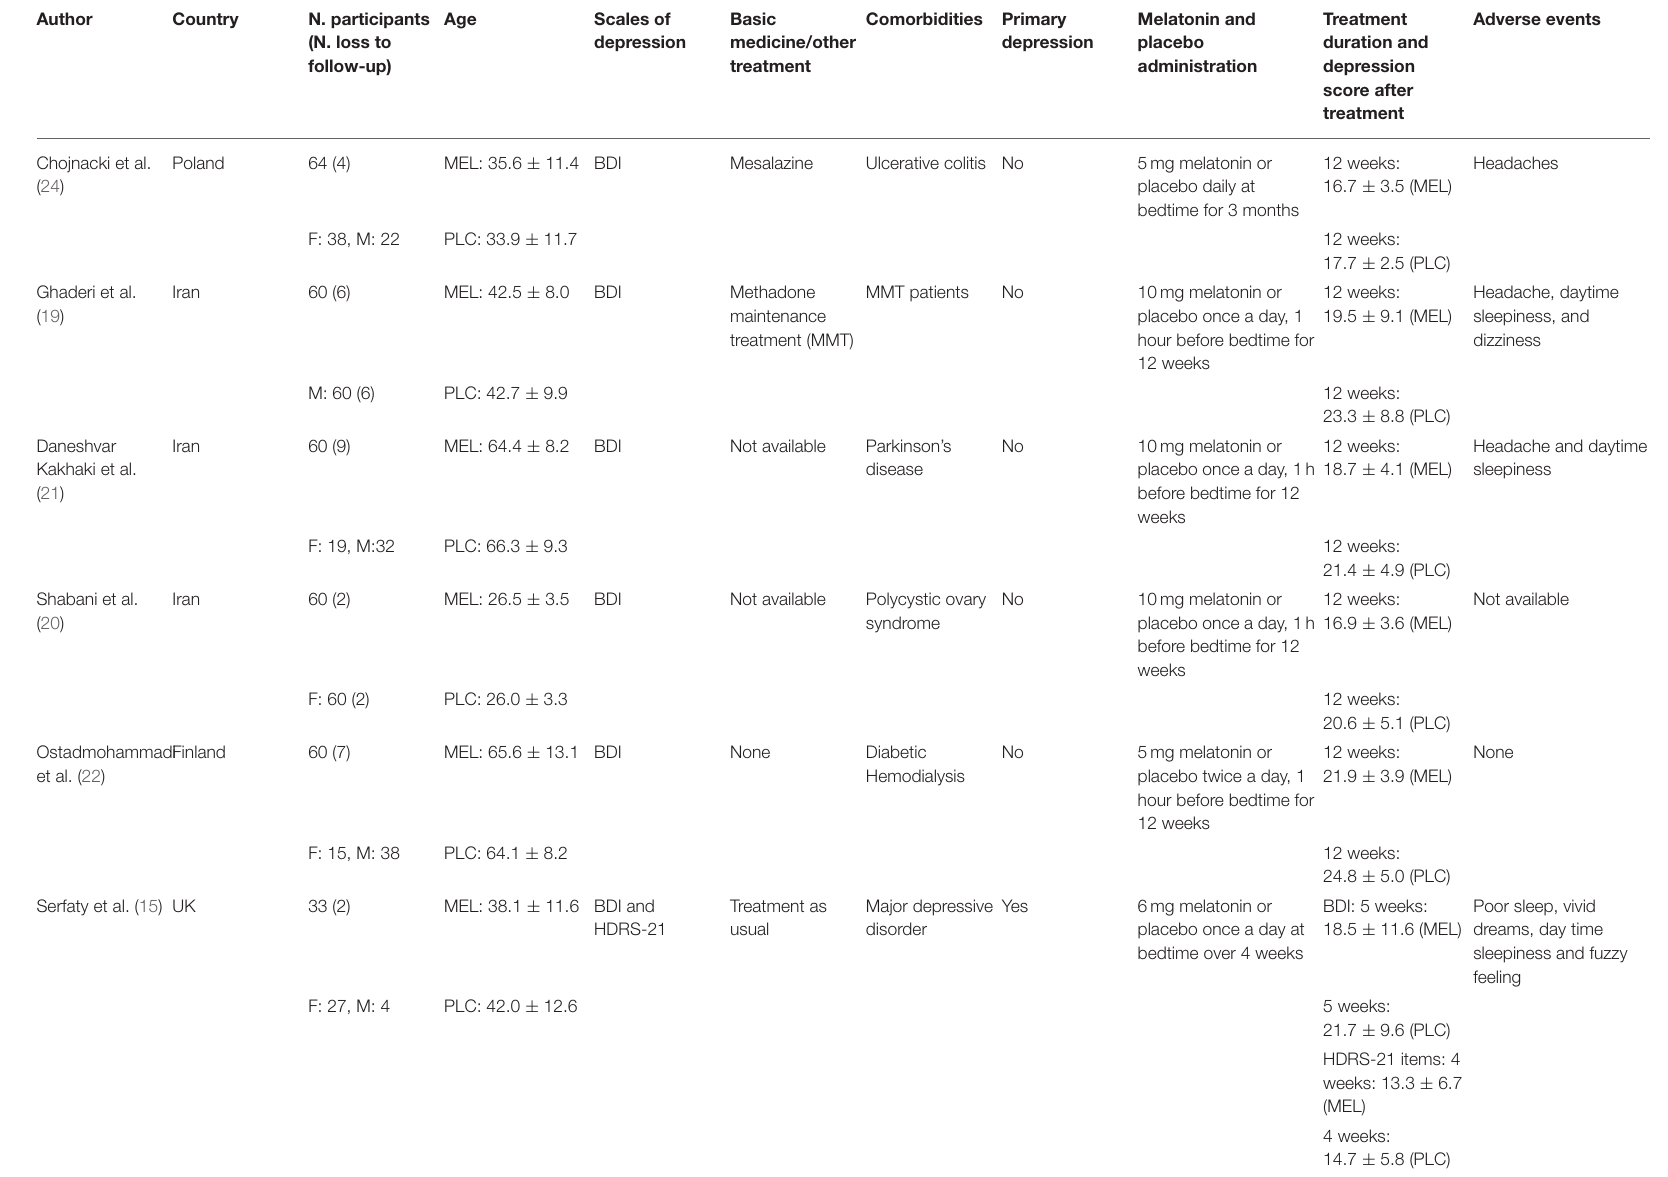
TABLE 1 | Characteristics of the included